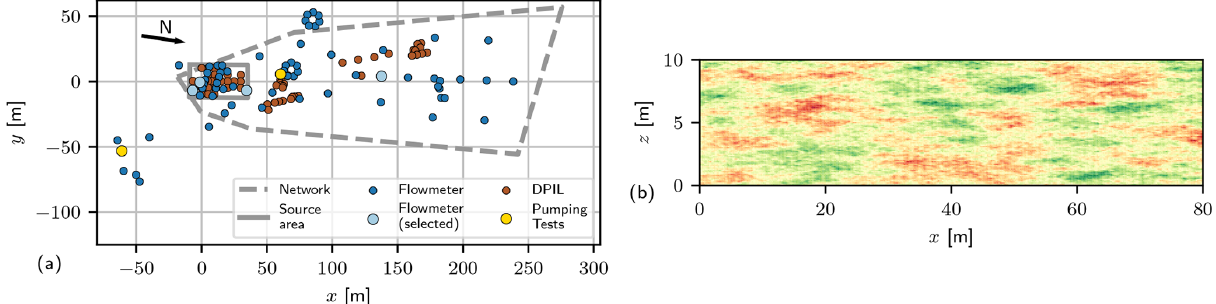
Figure 3. (a) Locations of measurements and tracer test observation network according to Boggs et al. (1990) and Bohling et al. (2016). (b) Gaussian random field with exponential co-variance structure as a conceptual module for small-scale conductivity (Module